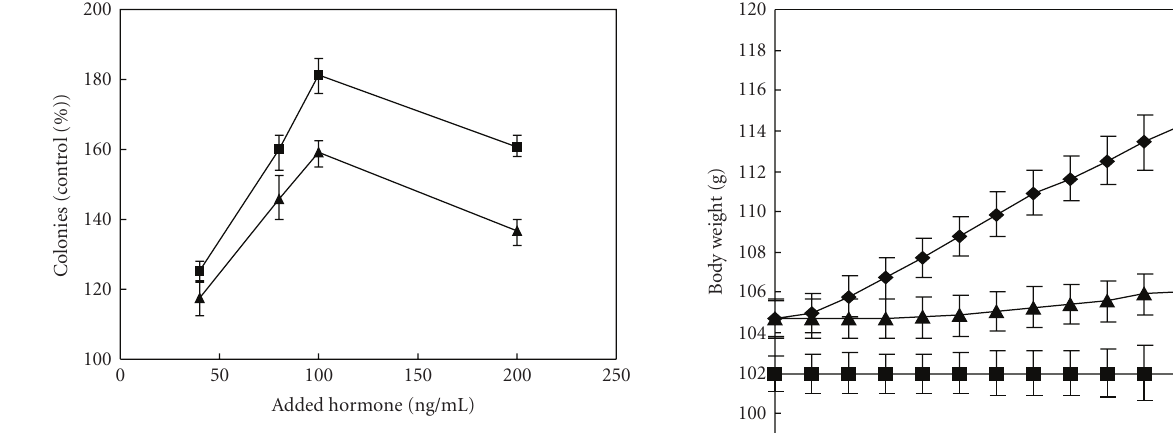
Figure 3: E ff ects of rhGH on erythroleukemia cell K562 colony formation. Most colonies were found at the dose of 100 ng/mL hGH and BmrhGH, respectively.